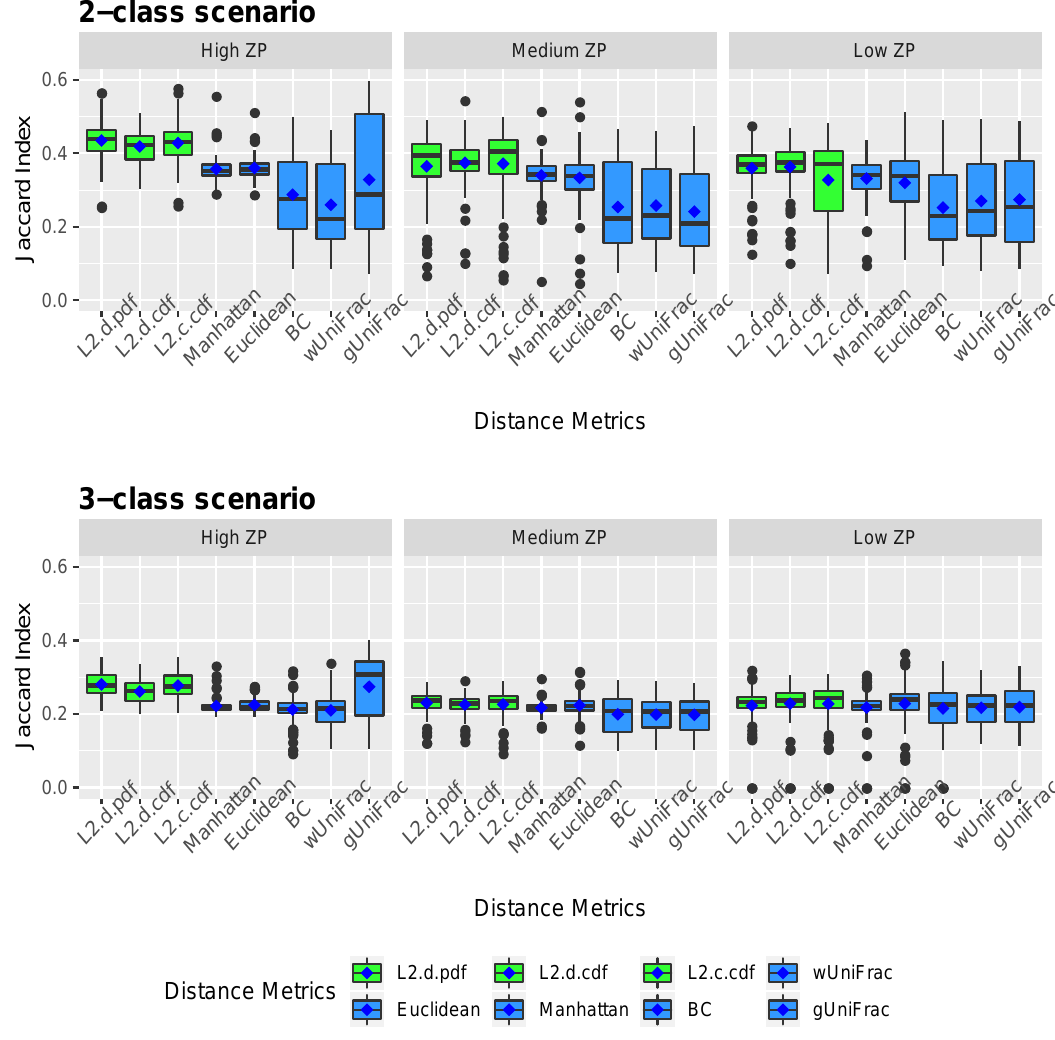
Figure 3. Jaccard index boxplots for simulated data. Two-subclass and three-subclass scenarios are considered. Three different cases of proportion of zeros (ZP) are evaluated - high ZP, medium ZP, and low ZP, are presented in left, middle, and right, respectively. For each box of the boxplots, the center line represents the median, the two vertical lines represent the 25th percentiles to the 75th percentiles. The whiskers of the boxplots show 1.5 interquartile range (IQR) below the 25th percentiles and 1.5 IQR above the 75th percentiles. The mean are shown in blue diamond